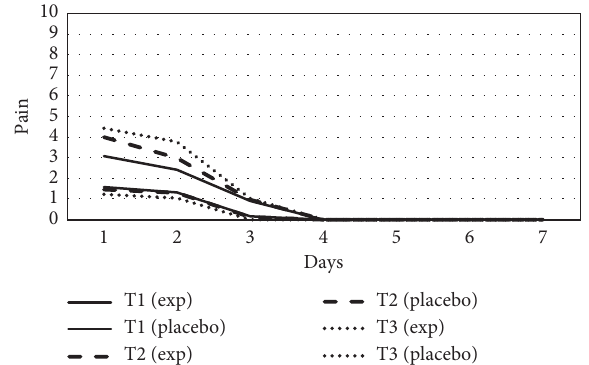
Figure 2: Comparison of pain among experimental side and placebo side in group A at T1, T2, and